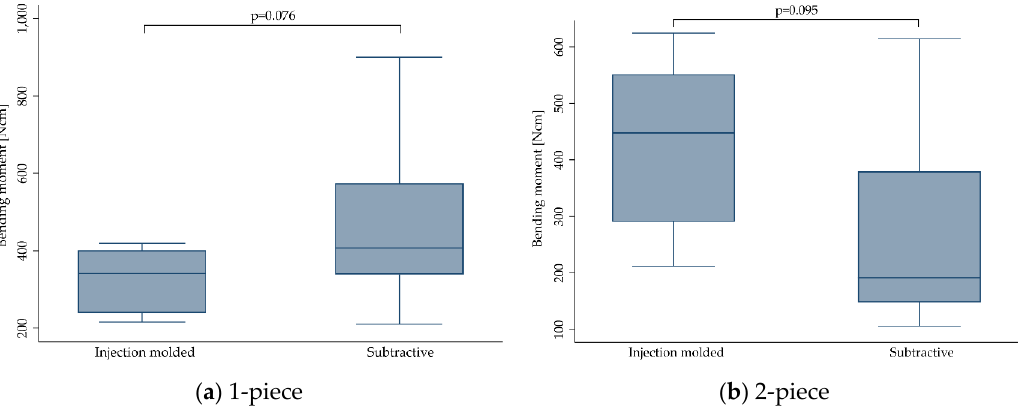
Figure 4. Boxplots showing the bending moment at the time point of fracture depending on the manufacturing method for 1- ( a ) and 2-piece ( b ) zirconia implants. Whiskers are used to represent all samples lying within 1.5 times the interquartile range. Detailed data can be found in Tables 3 and 4.